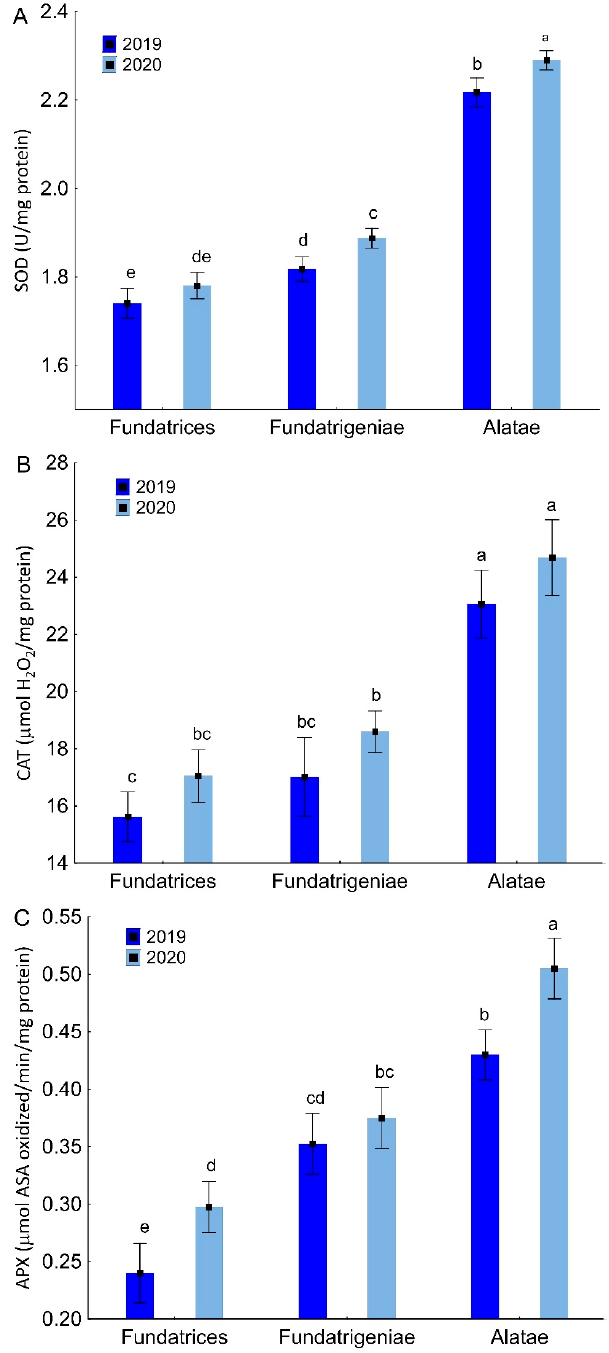
Figure 3. Superoxide dismutase (SOD) (U/mg protein) ( A ), catalase (CAT) (µmol H 2 O 2 /mg protein) ( B ) and ascorbate peroxidase (APX) activity (µmol ASA oxidized/min/mg protein) ( C ) in various morphs of A. fabae on V. opulus (means ± SD; n = 4). Different letters denote significant differences (one–way ANOVA; Tukey’s test; p <